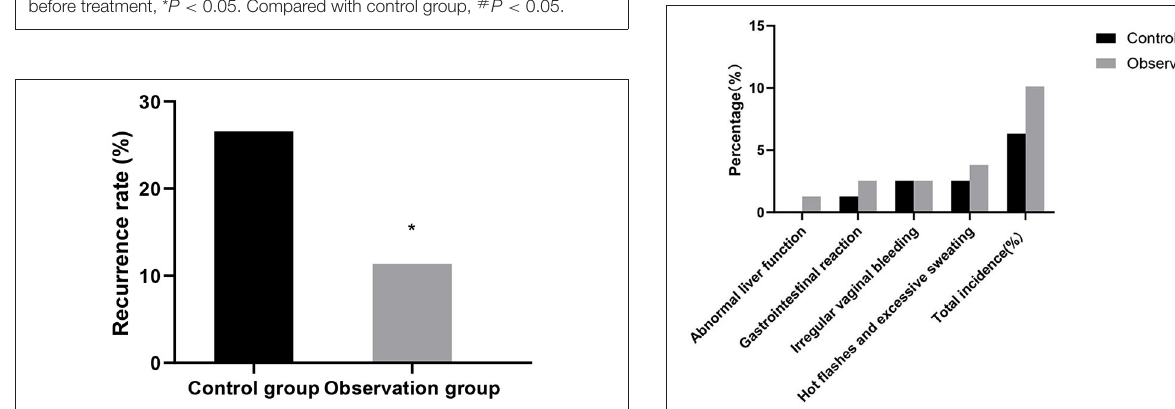
FIGURE 6 | Comparison of the incidence of adverse reactions between the two